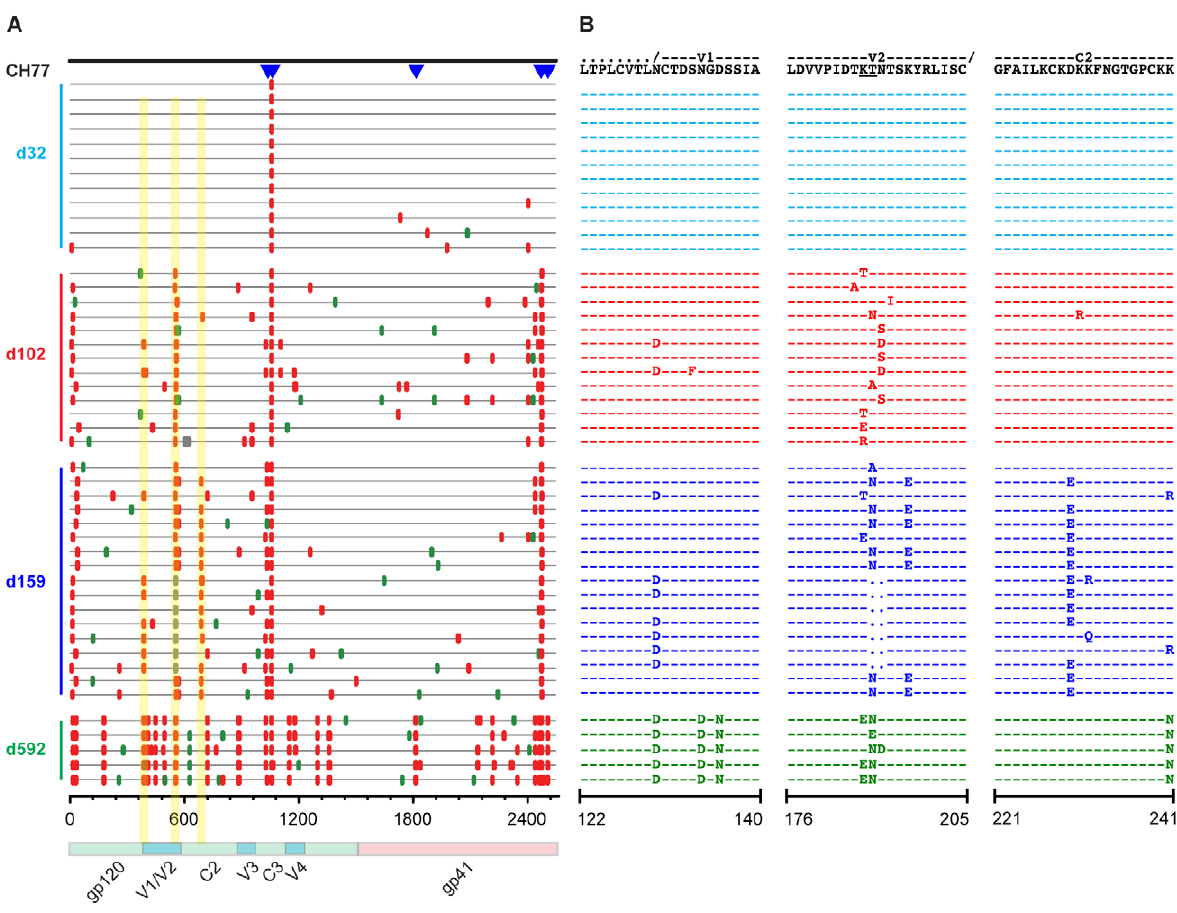
Figure 3. Highlighter analysis and env sequence alignments of putative Nab epitopes in subject CH77. A. Highlighter plots as described in Figure 2. B. Amino acid alignments of segments of V1, V2 and C2 regions as described in Figure 2. SGA sequences were obtained from 7 independent experiments.